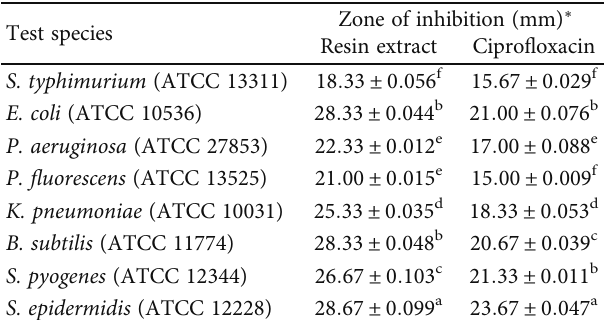
Table 2: In vitro antibacterial activity of C. myrrha oleo-gum extract against tested bacteria. Test